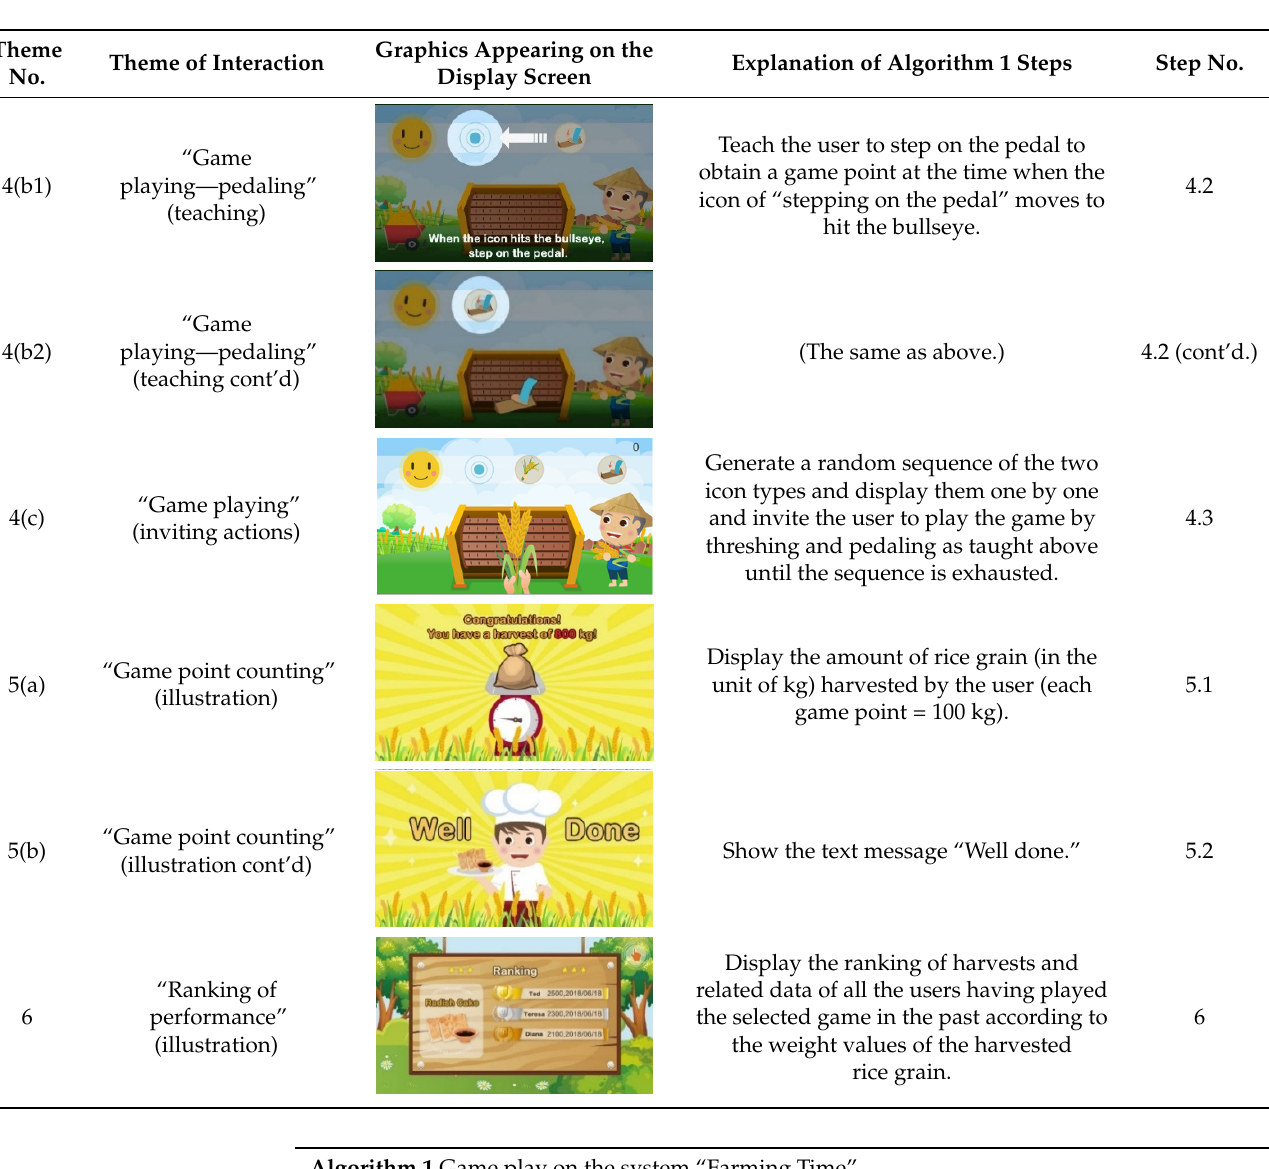
Algorithm 1 Game play on the system “Farming